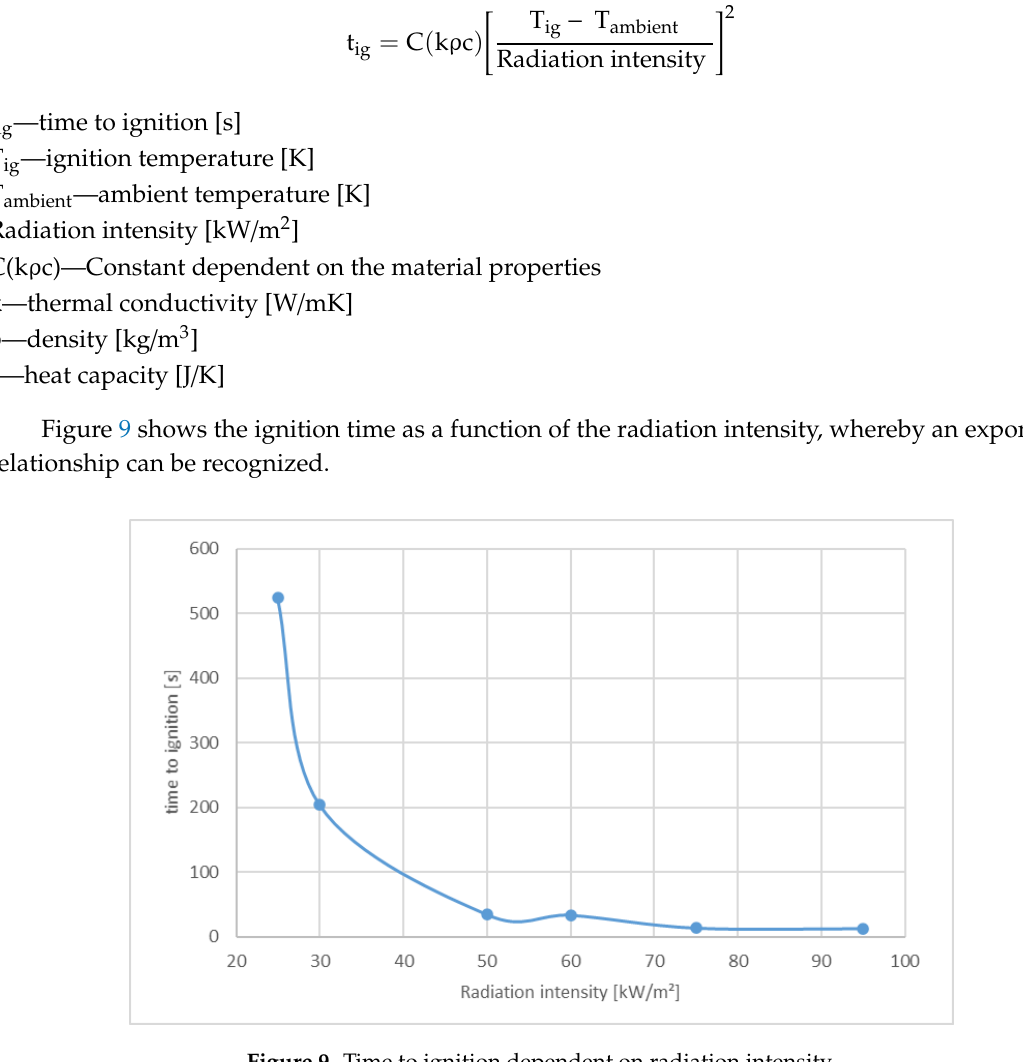
Figure 9. Time to ignition dependent on radiation intensity.